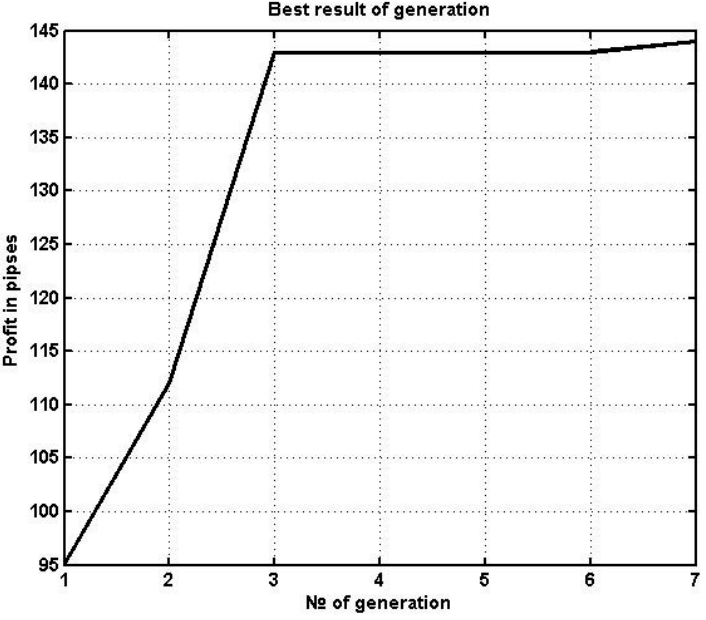
Figure 9. Profit increase during evolution.